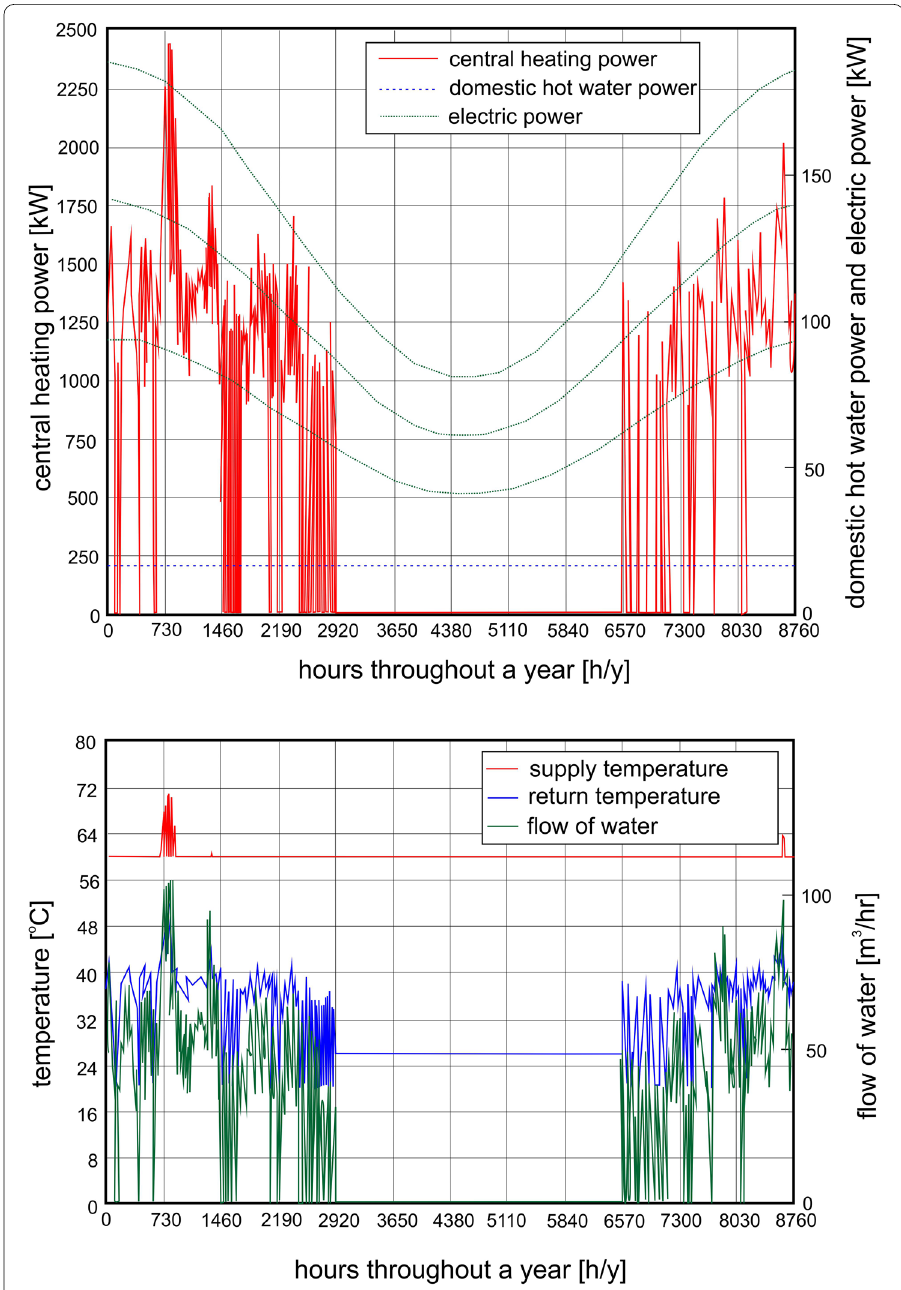
Fig. 13 Dynamic characteristics of the thermal and electrical power demand and the flow rate, supply and return temperature for the large greenhouse. P ch Q el 870 MWh/y. ( P ch —power demand–central heating, P dw —power demand–domestic hot water, P el — = electric power demand, Q ch —central heat use, Q dw —domestic hot water use, Q el —electricity